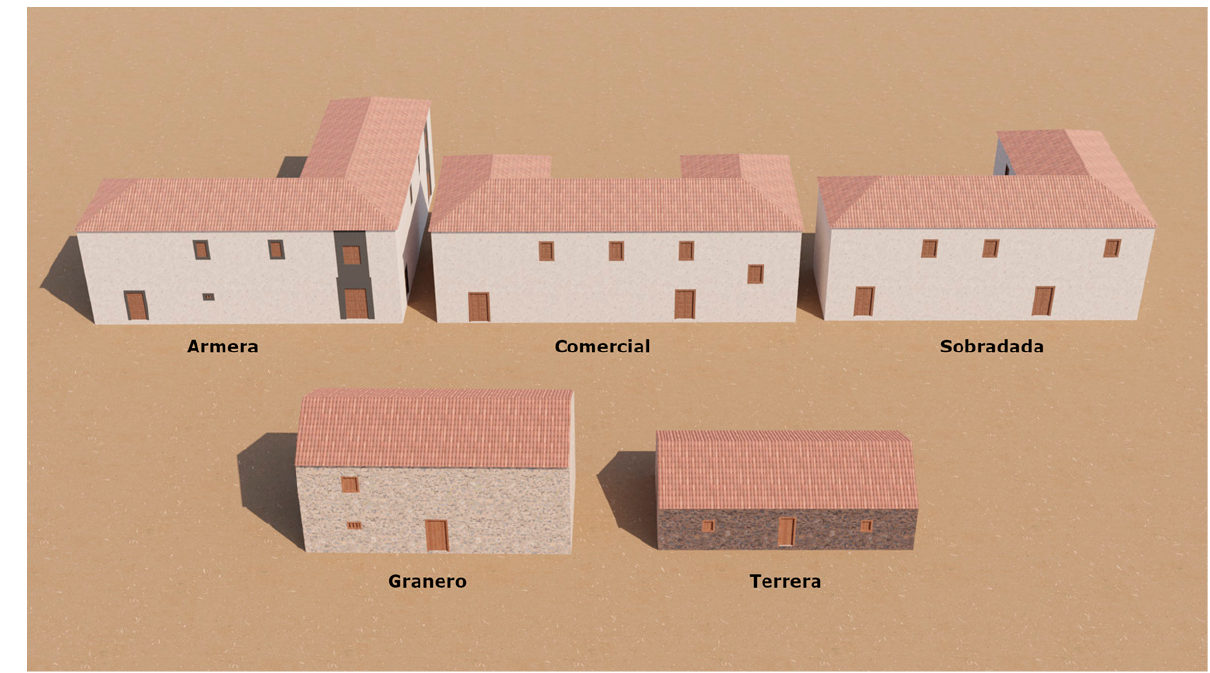
Figure 21. Random samples of 3D house models for the types of houses in Section 2.2.3: armera, comercial, sobradada, granero, and terrera.